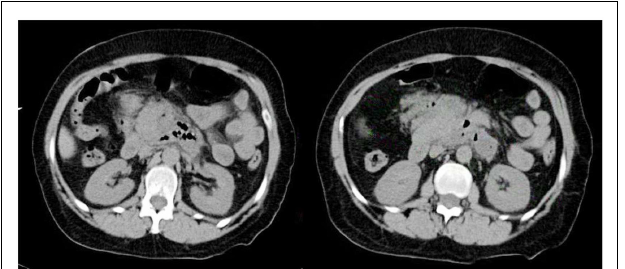
FIGURE 1 | CT of the abdomen shows an abnormal, poorly defined collection (6.9cm × 4.7cm) of gas and inflammatory changes in the region of the head and uncinate process of the pancreas and dorsal and inferior to the body of the pancreas. A more focal (2.1cm × 1.9cm) fluid density along the posterior left aspect is